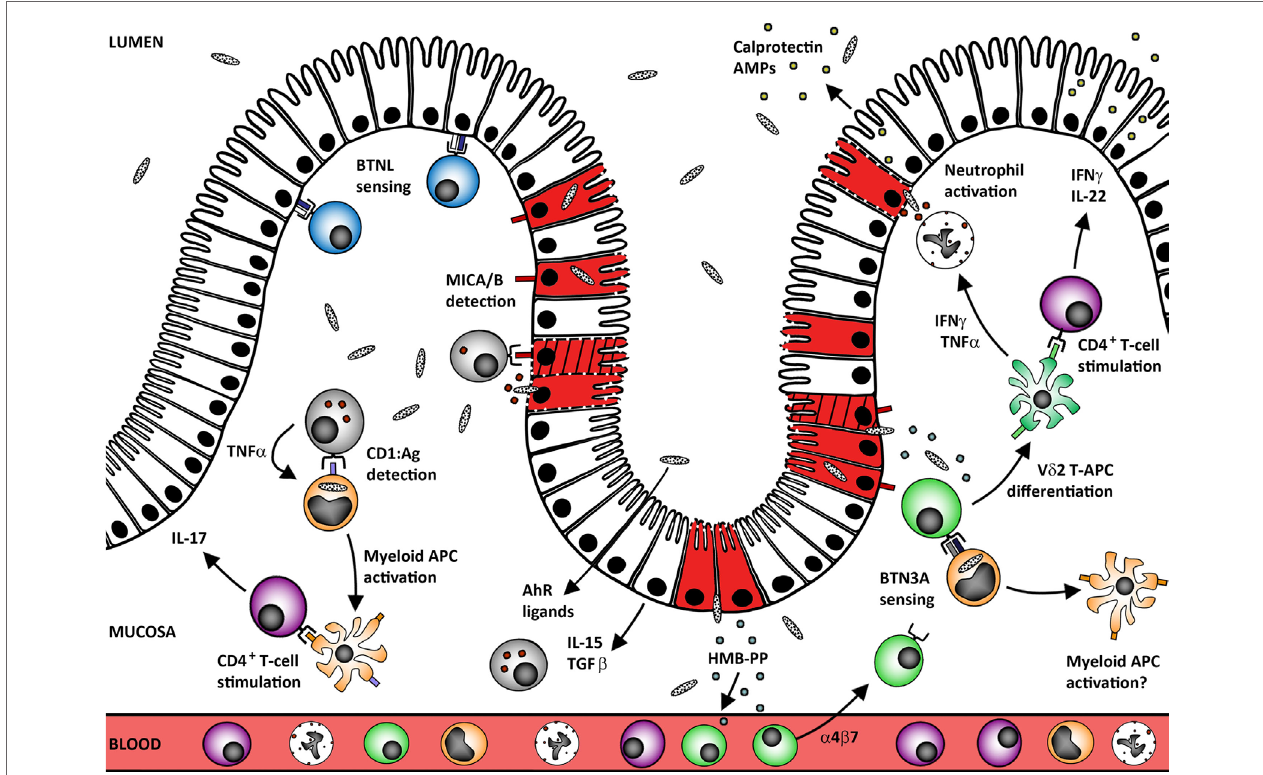
FigURe 1 | Human mucosal γδ T-cells protect the epithelial barrier against microbes and tumors. Tissue-resident γδ T-cells may develop in situ under the control of site-specific BTNL heterodimers that maintain these cells in a primed but inactivate state (blue V δ 1 + cells). Human mucosal barrier sites are also enriched in CD1 + myeloid APC (orange cells) that capture microbes and may undergo local TNF-induced maturation via self-antigen presentation to CD1-restricted γδ T-cells. The resultant mature APC can stimulate conventional αβ T-cell responses at the site of infection without the need to migrate through the draining lymphatics. Loss of BTNL signaling or upregulation of MICA/B expression by the infected/transformed/stressed epithelium (red/hatched/membrane-damaged cells) also triggers γδ T-cell cytotoxic responses that rapidly lyse the compromised cells (gray cells; both V δ 1 + and V δ 2 + subsets). Maintenance of these “epithelial surveillance” γδ T-cell populations is regulated by a complex variety of signals including local provision of AhR ligands, epithelial cytokine IL-15, and growth factor TGF- β . These factors likely also play critical roles in promoting tissue residence of recruited γδ T-cell populations. In the case of V δ 2 + T-cells (green cells), recruitment from the blood could be driven by ( E )-4-hydroxy-3-methyl-but-2-enyl pyrophosphate (HMB-PP) translocation across the defective mucosal barrier. Accumulation of microbial HMB-PP in the mucosa can then trigger BTN3A-mediated activation of V δ 2 + T-cells in the presence of IL-15 to promote differentiation into potent APC (and perhaps also reciprocal activation of local myeloid cell populations). This process supports rapid local generation of presenting cells that can stimulate CD4 + T-cell expression of barrier protectant cytokines, including IFN γ and IL-22 (purple CD4 + T-cells). These mediators promote epithelial release of antimicrobial peptides (AMPs) including calprotectin and cooperate with TNF α to promote neutrophil activation and